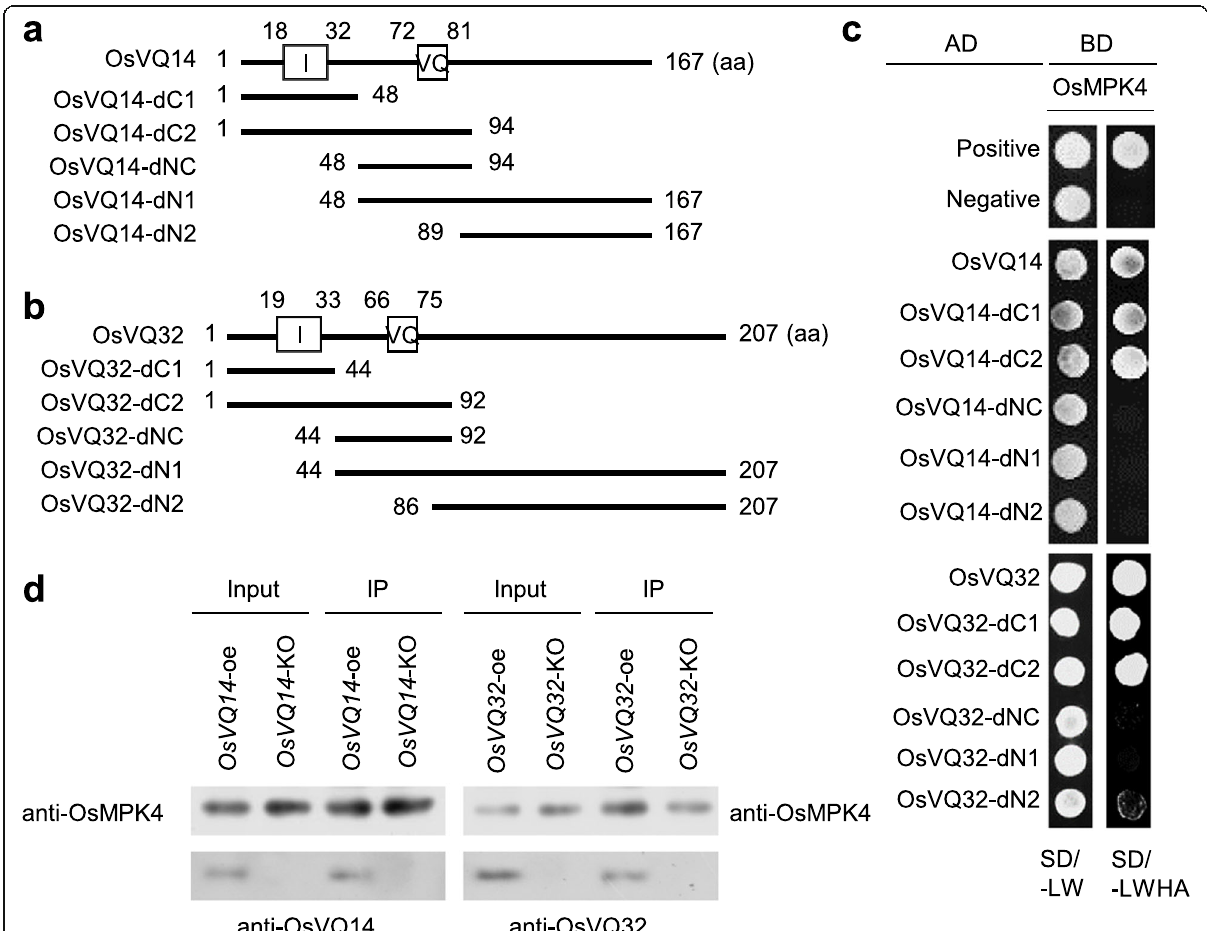
Fig. 3 OsVQ14 and OsVQ32 interacted with OsMPK4. a and b Schematic representation of OsVQ14 truncations ( a ) and OsVQ32 truncations ( b ). Rectangles “ I ” and “ VQ ” mean domain I and VQ domain, respectively. c Interaction of OsMPK4 with OsVQ14 or OsVQ32 was analyzed by yeast two-hybrid assay. The interactions were assessed by growing yeast cells on synthetic defined premixes (SD) medium lacking ( − ) leucine (L), tryptophan (W), histidine (H), and adenine (A). Co-transformation of BD-53 and AD-RecT was used as positive control while co-transformation of BD-Lam and AD-RecT was used as negative control. AD, Activation domain; BD, DNA-binding domain. d Interaction of OsMPK4 with OsVQ14 or OsVQ32 in rice plants was analyzed by co-immunoprecipitation assay. Total protein was extracted from rice leaves and anti-OsMPK4 antibody was used for the immunoprecipitation